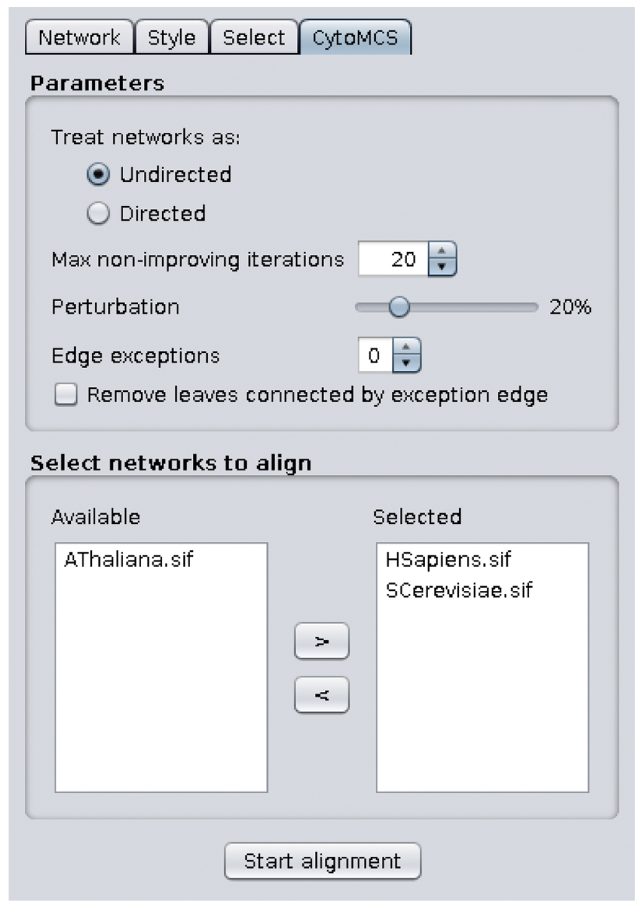
Figure 2: The CytoMCS app ’ s control